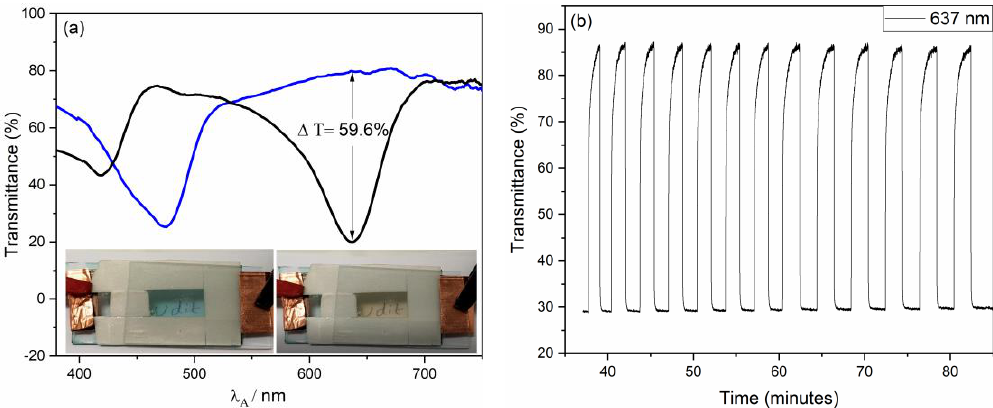
Figure 8. ( a ) Photographs and UV/vis transmittance spectra of Fe-MSP electrochromic device in the reduced colored state (black curve, 0 V) and oxidized bleached state (blue curve, 1.4 V); ( b ) optical response of the device to periodic voltage cycling.